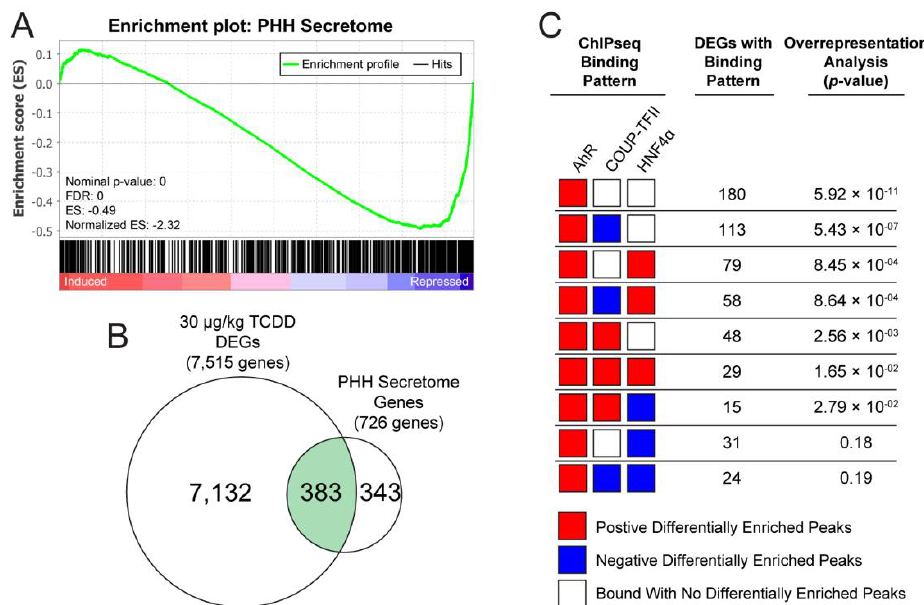
Figure 7. TCDD dose-dependently repressed expression of liver-specific secretome genes. Loss of liver function was assessed by examining changes in hepatic secretome gene expression. A putative primary human hepatocyte (PHH) secretome of 691 genes has been previously reported that was mapped to 726 mouse orthologues (Franko et al., 2019). ( A ) A gene set enrichment analysis for 726 mouse orthologs of the human PHH secretome was conducted using data for C57Bl/6 male mice orally gavaged with 30 ug/kg TCDD every 4 days for 28 days. ( B ) Differential gene expression was assessed for genes encoding the PHH secretome in mice treated with 30 µg/kg TCDD every 4 days for 28 days. ( C ) Over-representation analysis of select transcription factor binding patterns for the 383 PHH secretome DEGs was performed using a one-sided Fisher’s exact test with FDR correction. Over-representation analysis of all transcription factor binding patterns is available in Supplementary File S3.